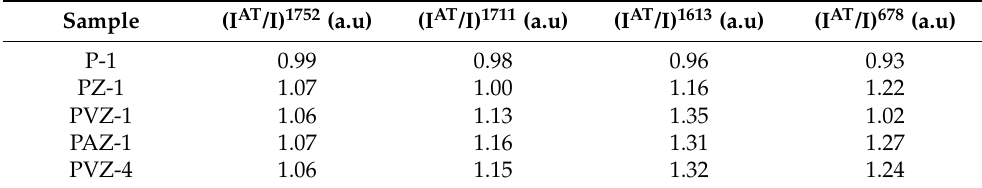
Table 3. Relationship between intensities of wavelengths associated with PVDF degradation products before and after (AT) photocatalytic oxidation tests